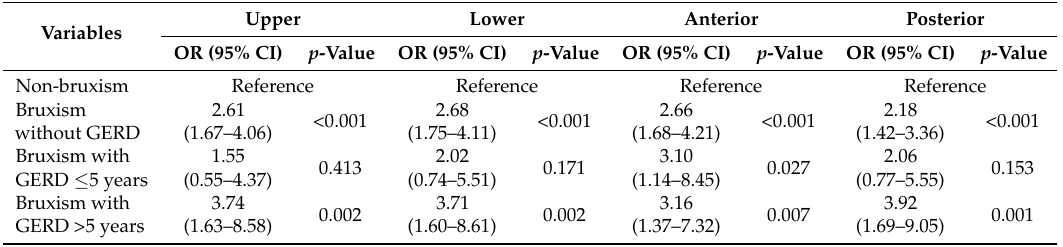
Table 7. Associations among bruxism, GERD, and severe tooth wear for different tooth locations after adjustment 1